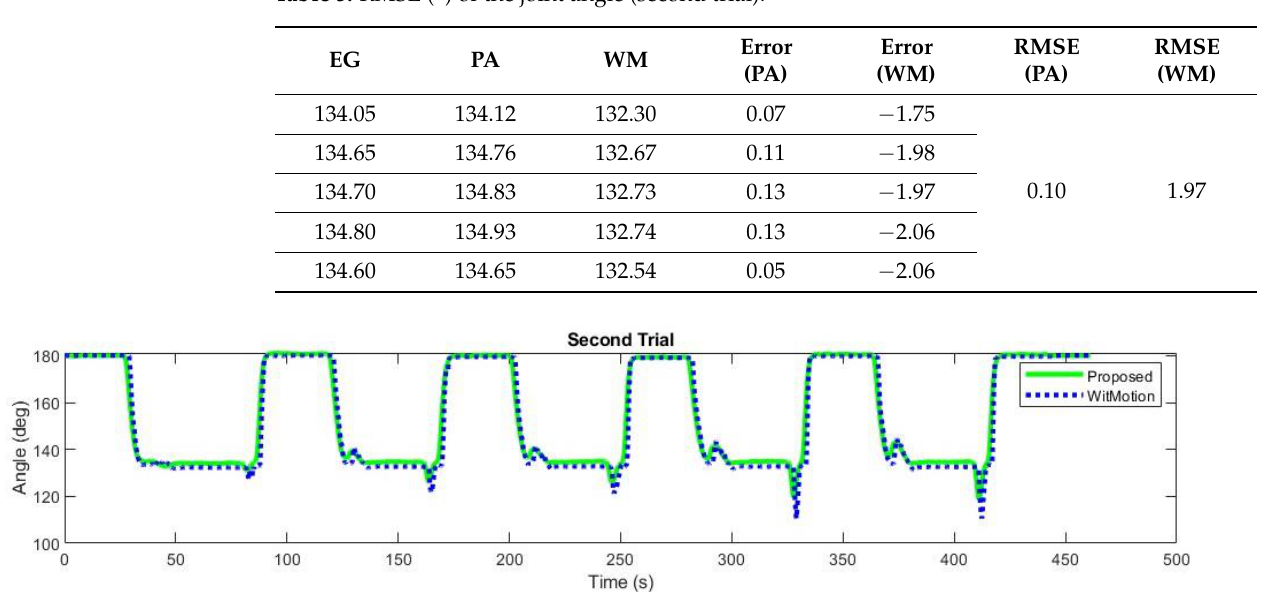
Table 5. RMSE ( ◦ ) of the joint angle (second trial).